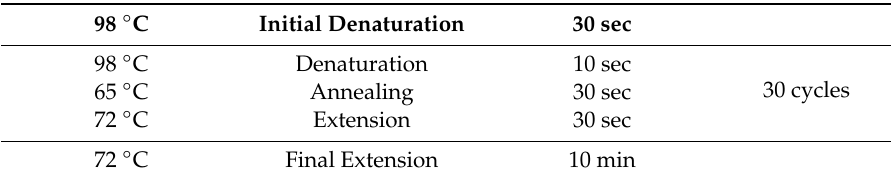
Table A2. Cycling conditions for triplex PCR detection of aadA5 , bla CTX-M-15 , and tetA present on plasmid